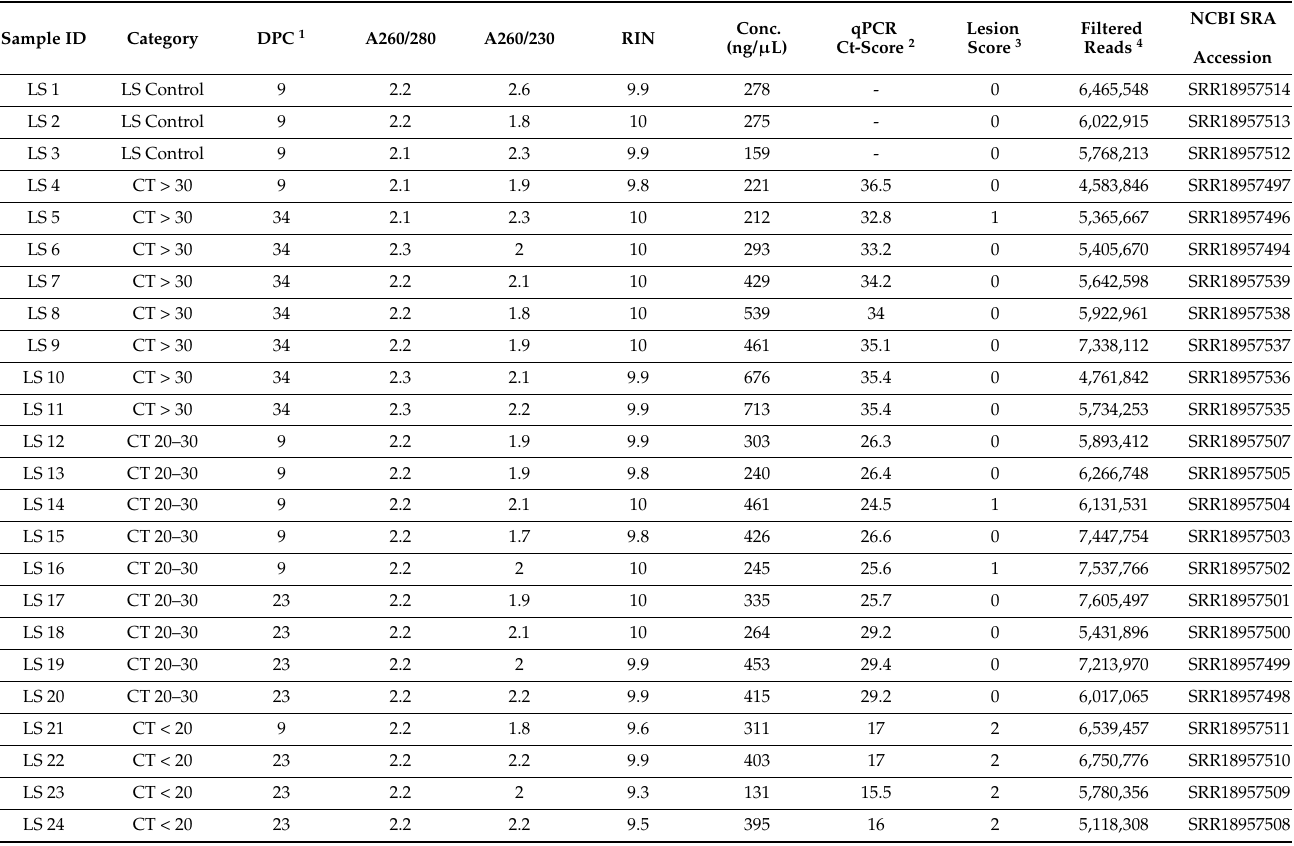
Table 2. Summary of LS samples, time points, RNA-extraction, Moritella measurement by qPCR, winter-ulcer-related lesion scores, and SRA accession